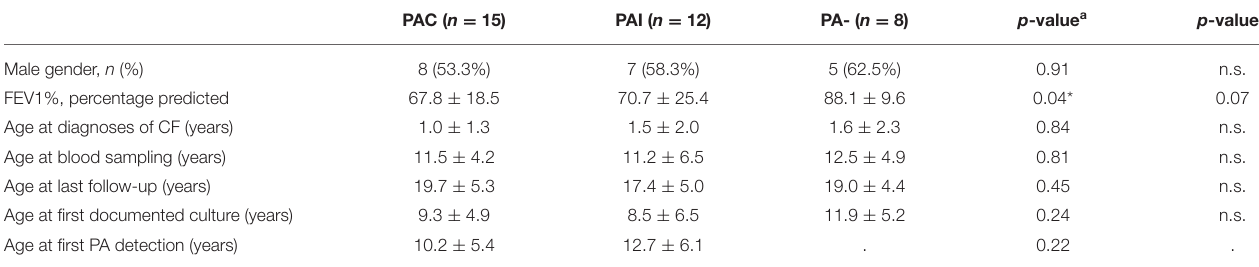
TABLE 1 | Clinical features of the study population.